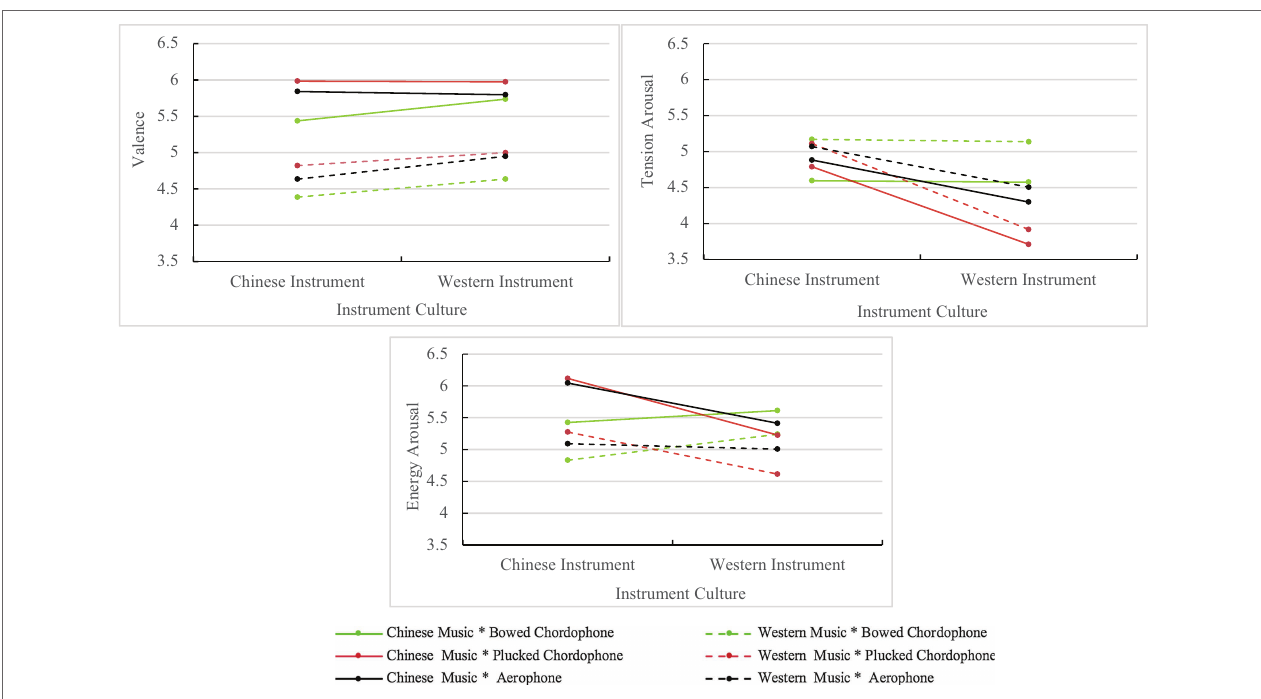
FIGURE 2 | Results of the three-way interaction between instrument category, instrument culture, and musical culture of melodies for valence ( upper left ), tension arousal (upper right) , and energy arousal (lower center)